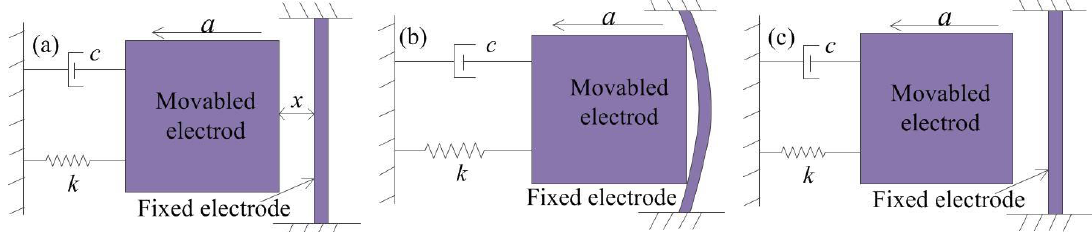
Figure 4. Contact process of inertial switch with simply supported beam. ( a ) the acceleration is applied to inertial switch with fixed electrode of simply supported beam, ( b ) the fixed electrode of the simply supported beam has elastic deformation due to the inertia impact of movable electrode, ( c ) the movable electrode returns to its original position.